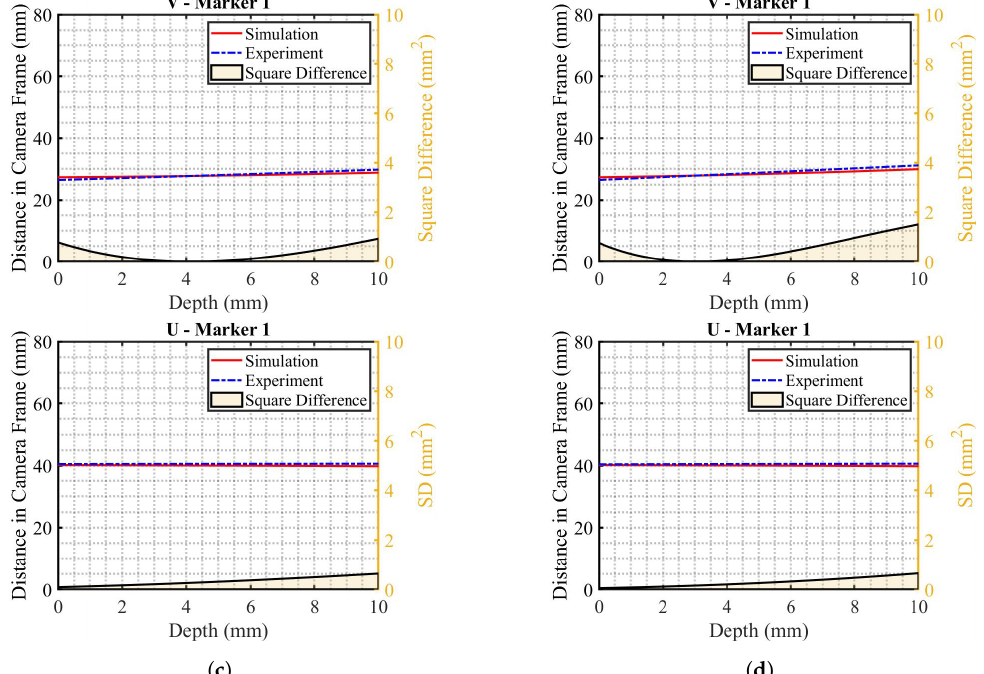
Figure A1. The deformation in U and V directions and the error between simulation and experiment over a pressing stroke of 10 mm for different angles. ( a ) Normal configuration of 0 ◦ . ( b ) Inclined configuration of 4 ◦ . ( c ) Inclined configuration of 8 ◦ . ( d ) inclined configuration of 12 ◦